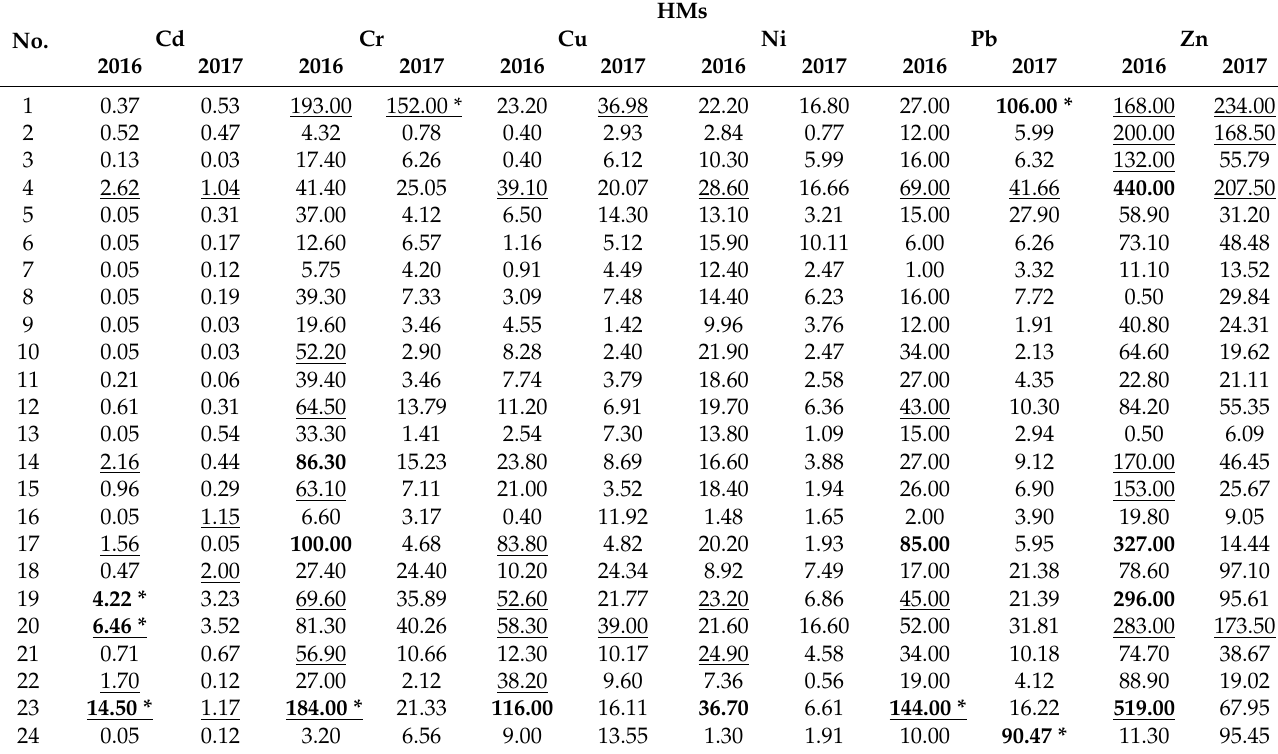
Table 5. Concentrations of heavy metals in the bottom sediments of Warta River (mg · kg − 1 ) in 2016 and 2017 on the background of ecotoxicological criteria.